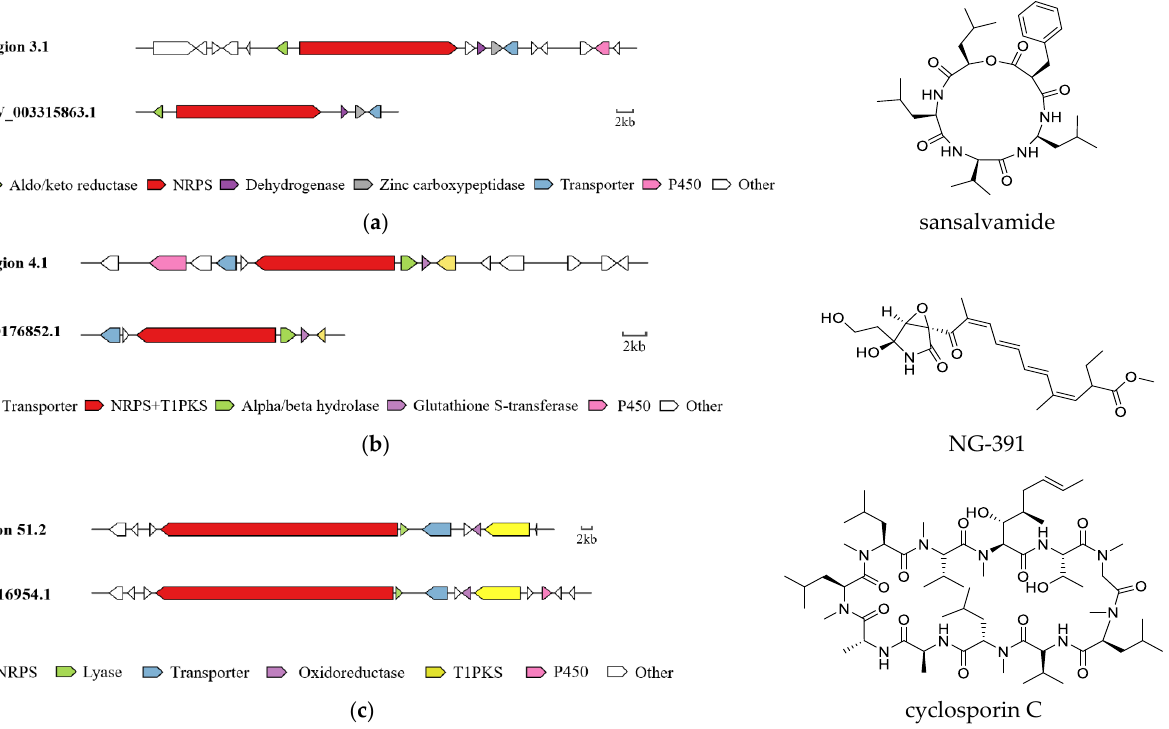
Figure 5. CAZy functional classification and the number of corresponding genes of strain R1.